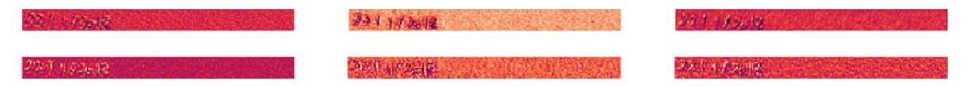
Figure 9. Experimental results of the Yolov5 model: ( a ) mean average precision of 0.5 confidence; ( b ) mean average precision of 0.5 to 0.95 confidence; ( c ) precision; ( d ) recall; ( e ) train box loss; ( f ) train object loss; ( g ) train class loss; ( h ) the learning rate.